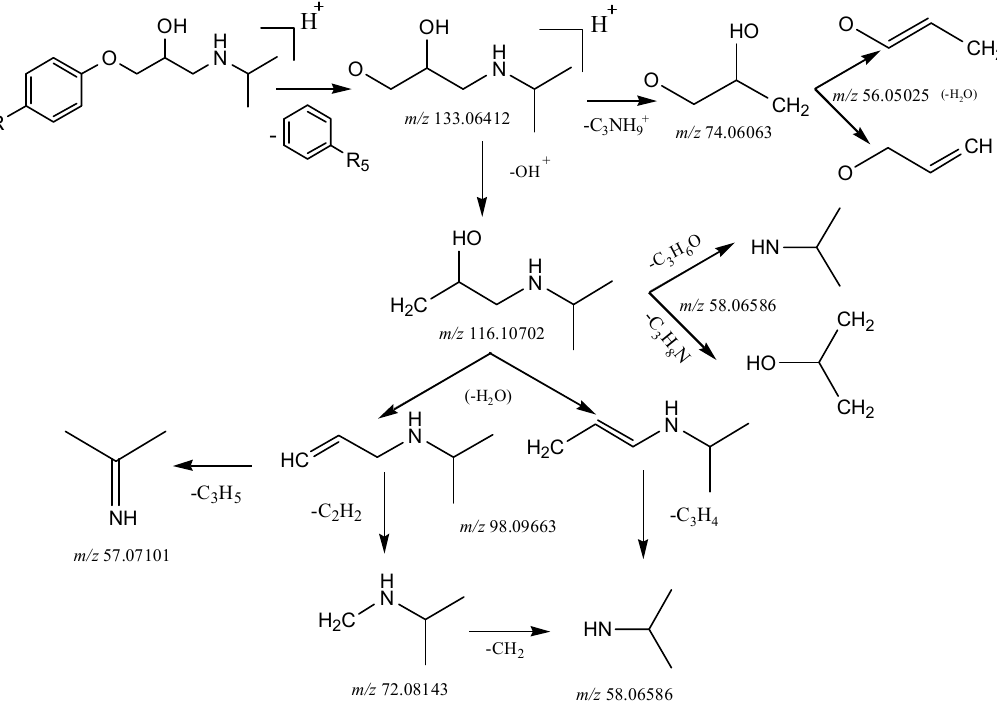
Figure 4. The suggested fragmentation pathways of aryloxypropanolamine compounds.